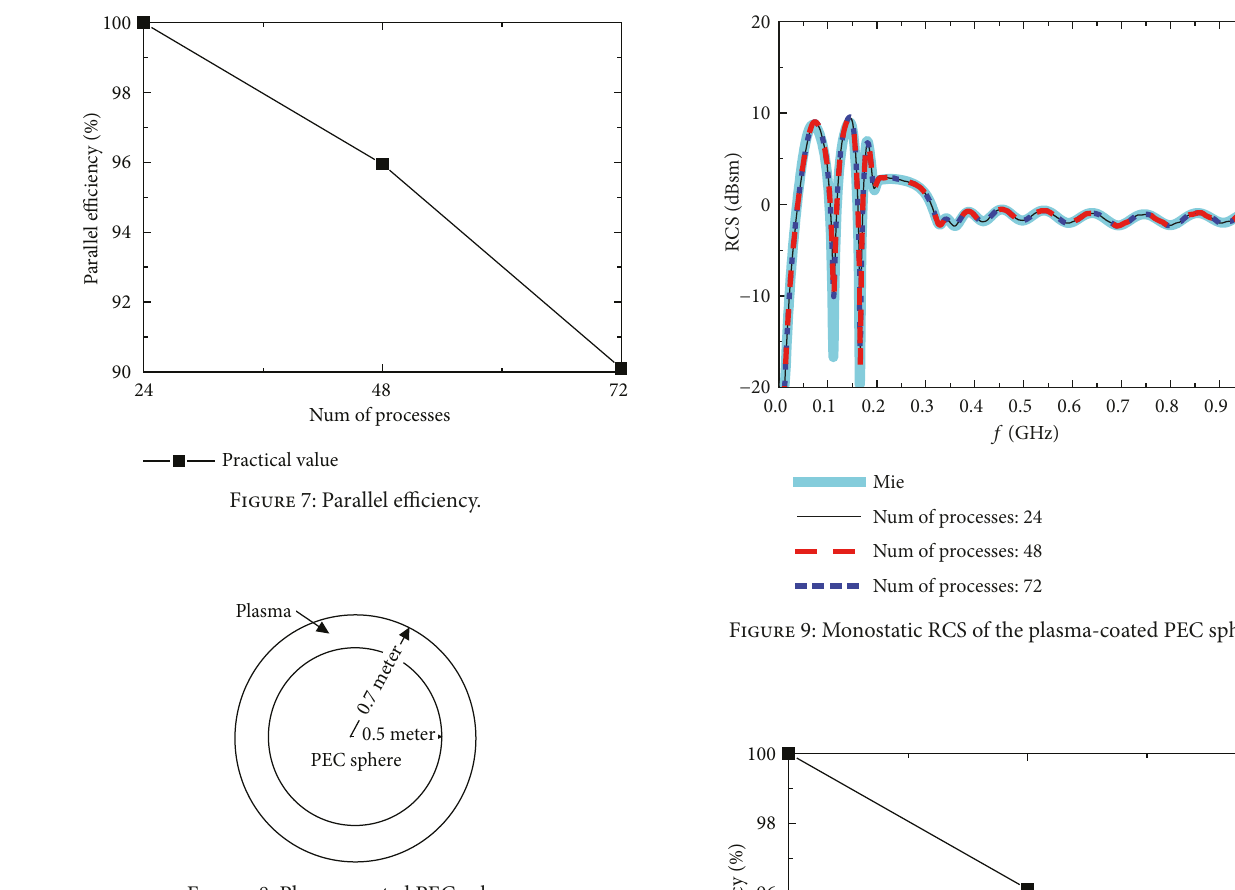
Figure 8: Plasma-coated PEC sphere.